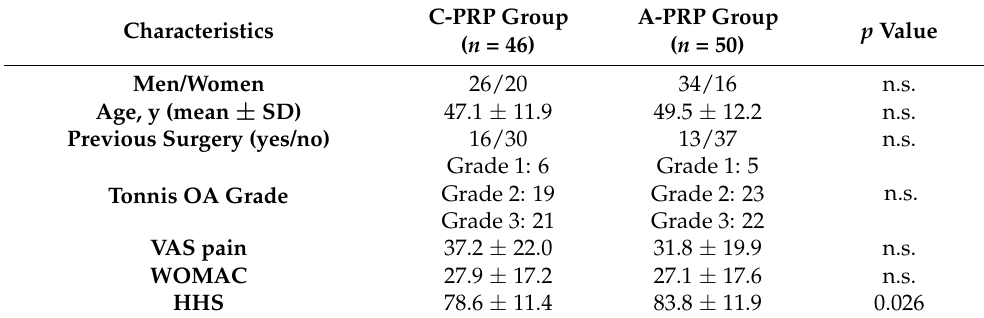
Figure 1. Workflow of the study. A-PRP, autologous platelet-rich plasma; C-PRP, cordonal platelet- rich plasma; pts, patients. Table 1. Baseline demographic and clinical characteristics of the included patients of both groups.